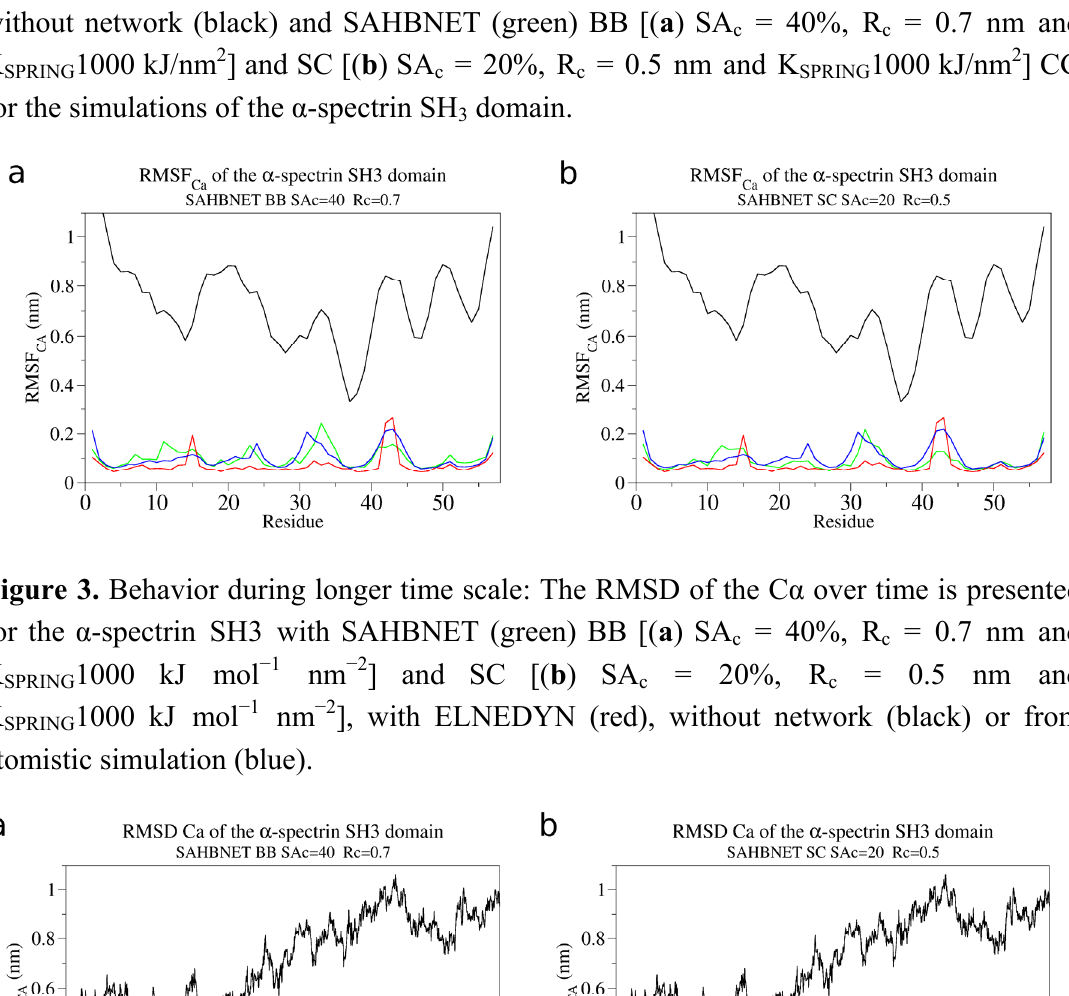
Figure 2. Comparison of the RMSF of the C α between atomistic (blue), ELNEDYN (red), without network (black) and SAHBNET (green) BB [( a ) SA K 1000 kJ/nm 2 ] and SC [( b ) SA SPRING for the simulations of the α -spectrin SH